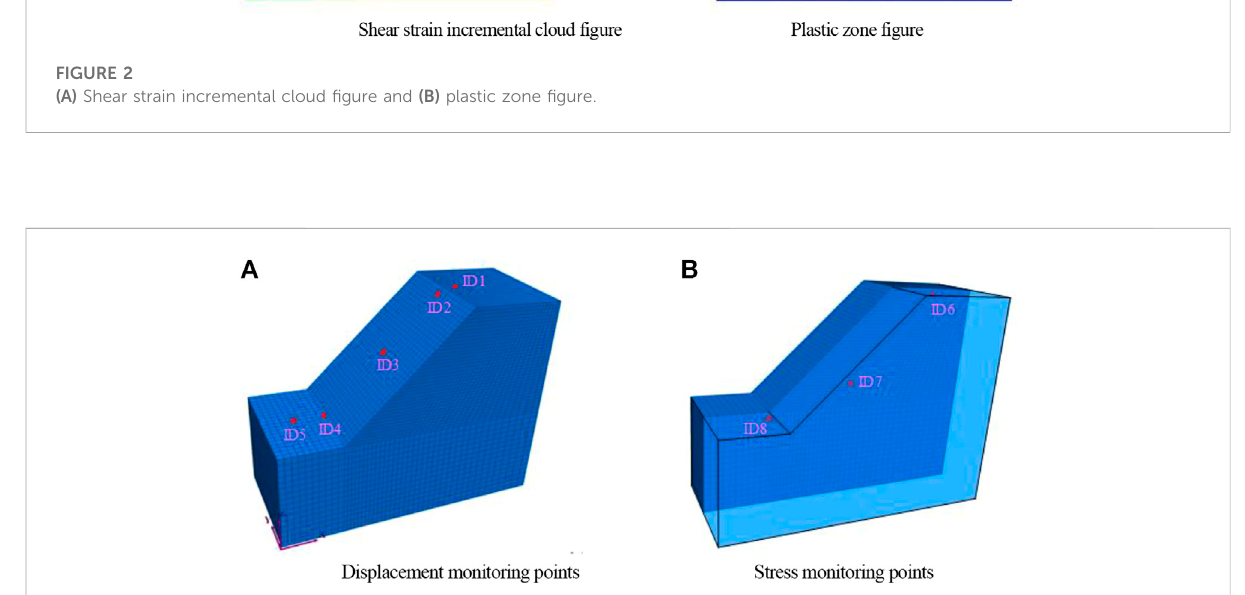
FIGURE 3 Monitoring point arrangement plan. (A) Displacement monitoring points (B) Stress monitoring